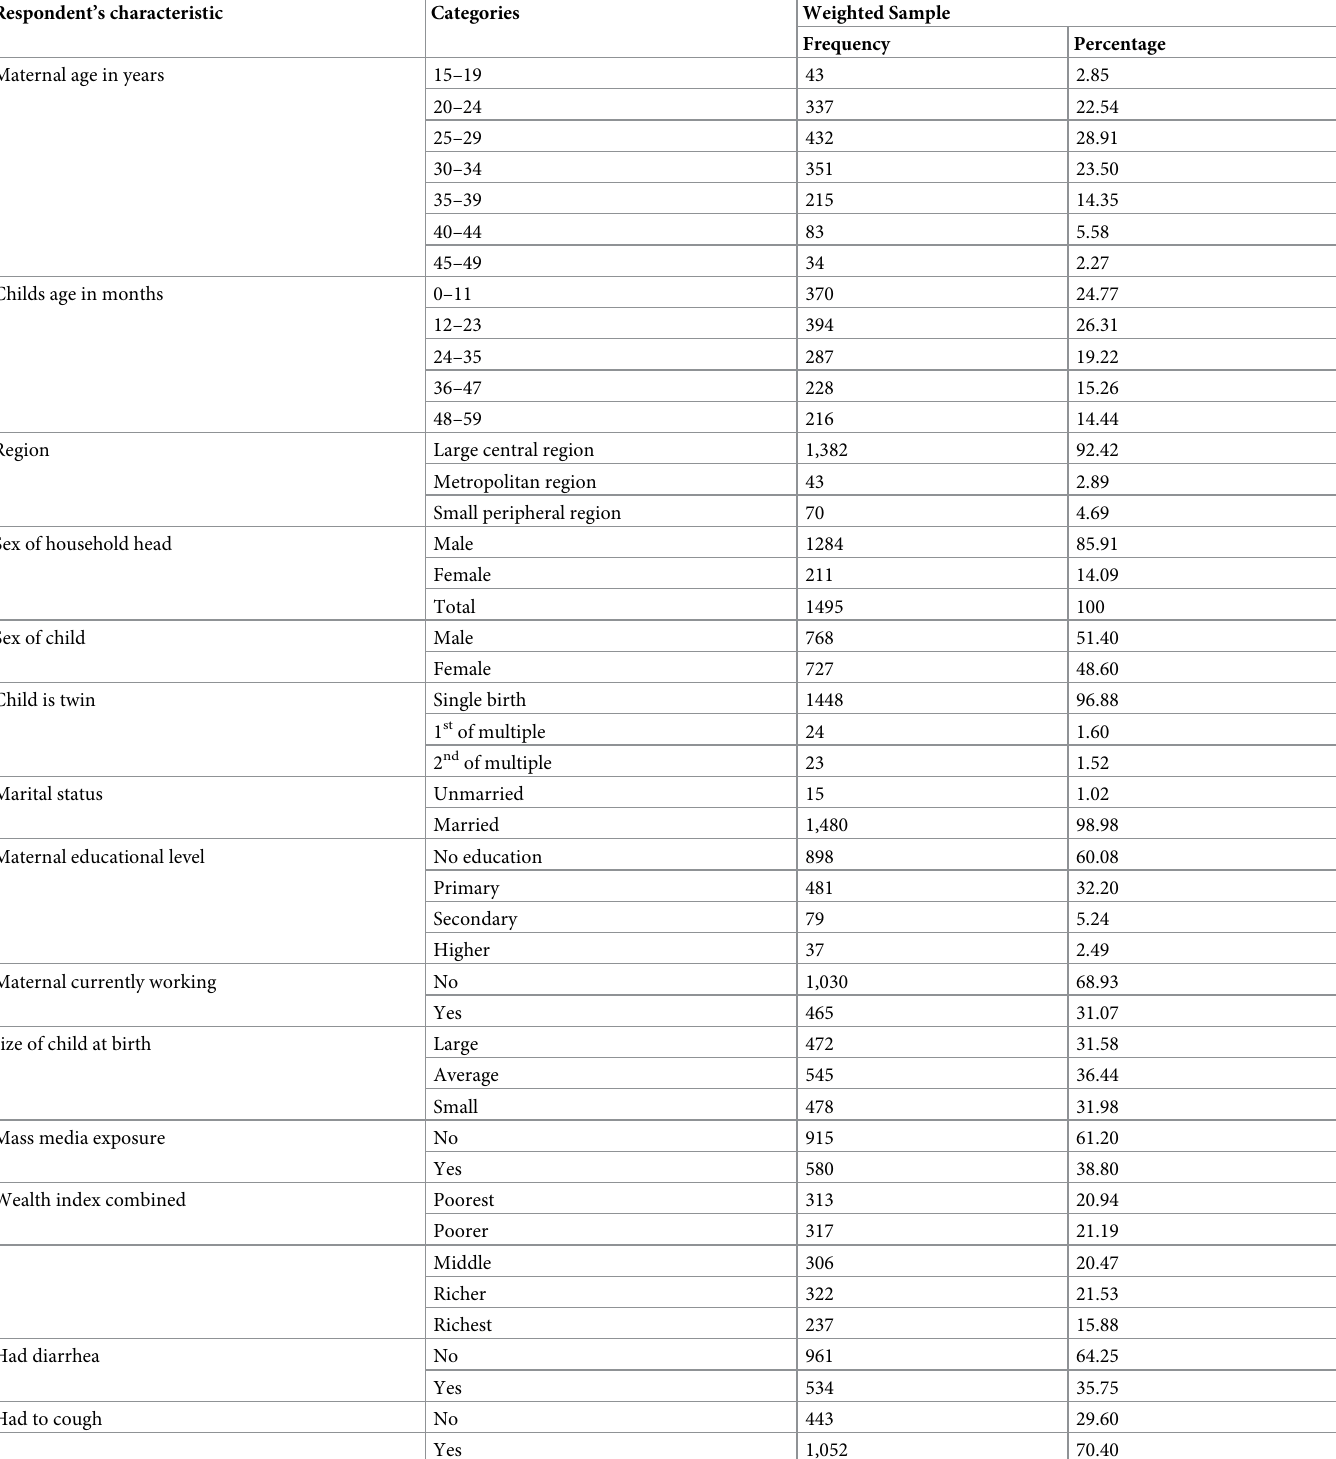
Table 1. Weighted socio-demographic and health-related characteristics of the study participants in Ethiopia, 2016(n = 1354; weighted sample =